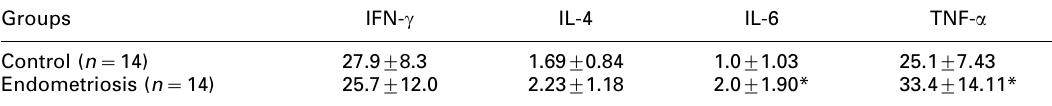
Table 2. The peripheral blood T-cell percentages expressing intracellular deposits of IFN- g , IL-4, IL-6 and TNF- a Groups